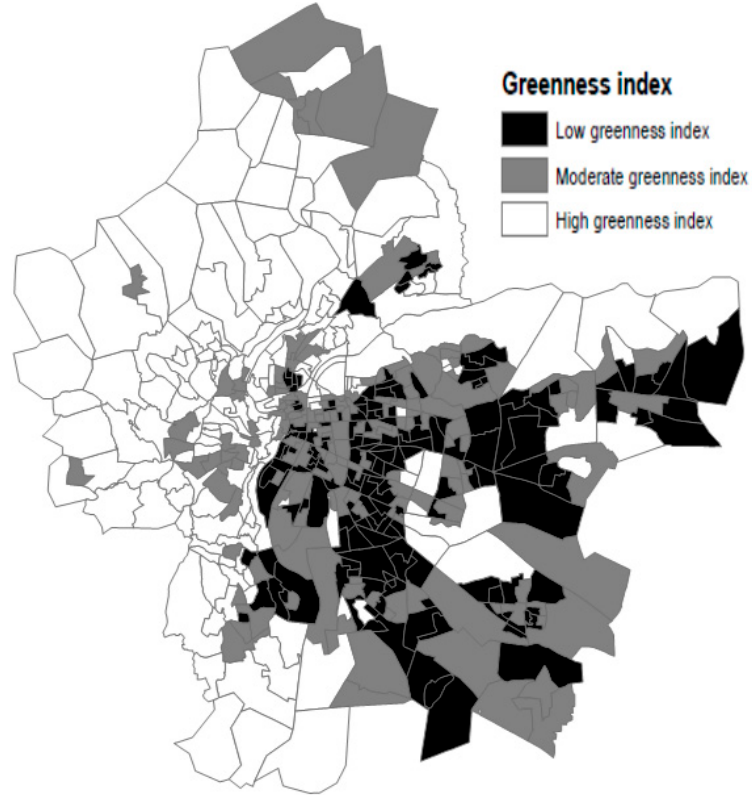
Figure 5. Spatial distribution of green space exposure, at census block level, based on tertiles of the